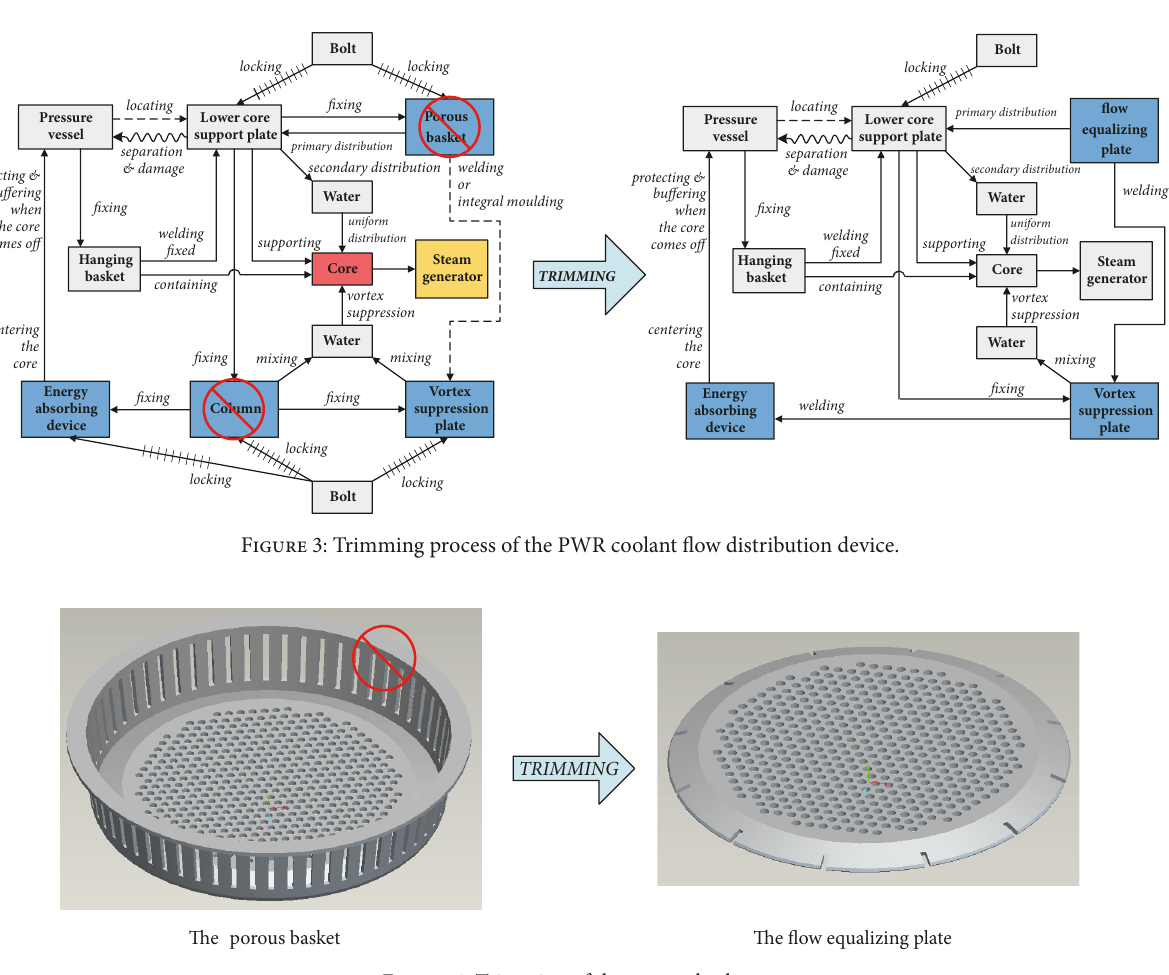
Figure 4: Trimming of the porous